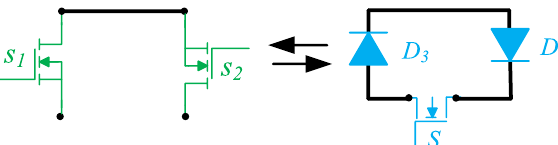
Figure 6. Equivalent synchronous switch for S 1 and S 2